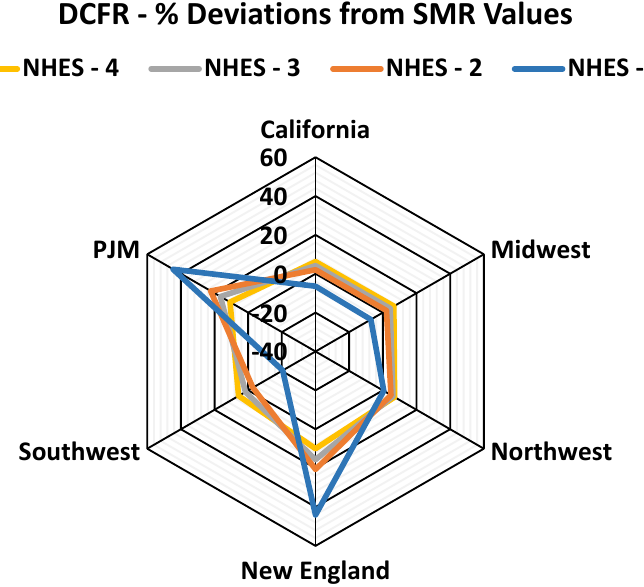
Figure 11. Percentage deviation of DCFR for different NHES scenarios from SMR values.